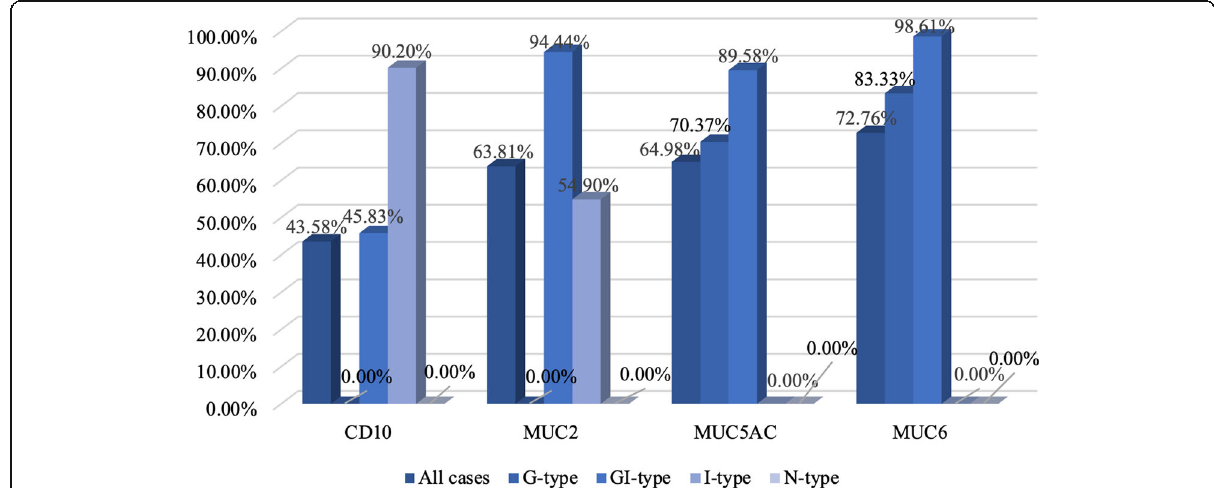
Fig. 1 The proportion of CD10, MUC2, MUC5AC, and MUC6 in each mucin